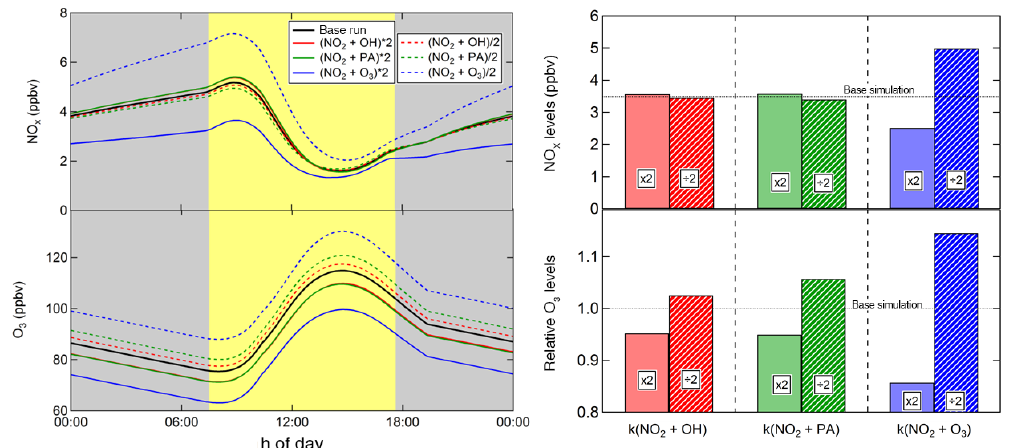
Figure 10. The effect on NO x and ozone concentration of changing the rates of select reactions in a box-model simulation. The reaction NO 2 + O 3 represents the nighttime reaction pathway to HNO 3